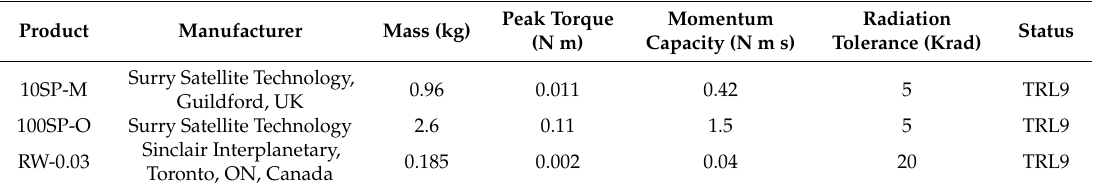
Table 15. Small Space Craft Reaction Wheel Performance Data [23].